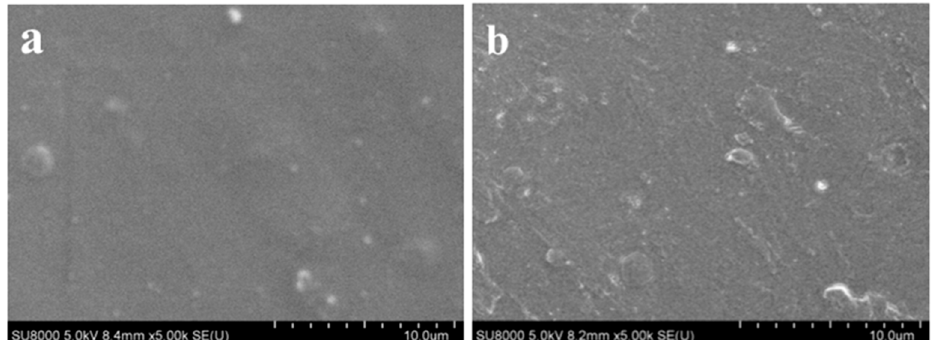
Figure 2. Micro morphology of dried polymeric film ( a ) C1 and ( b ) DeconGel 1101.